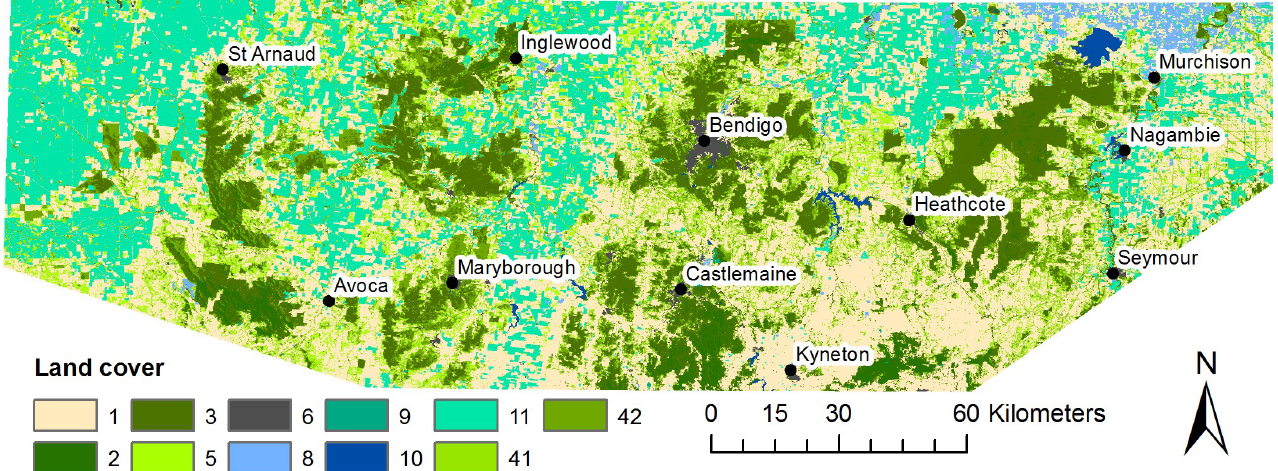
Fig 2. Land cover classes and major towns within the study area. Different land cover classes are shown by shading (see Table 1 for details). Continuous forest cover is shown in dark green.